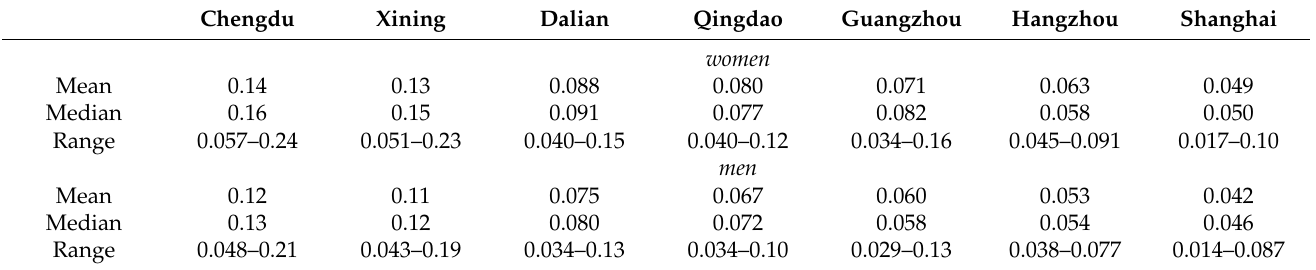
Table 2. Estimated daily intake of MPs (items/kg bw/day) through using TOFCs for general Chinese population in different Chinese